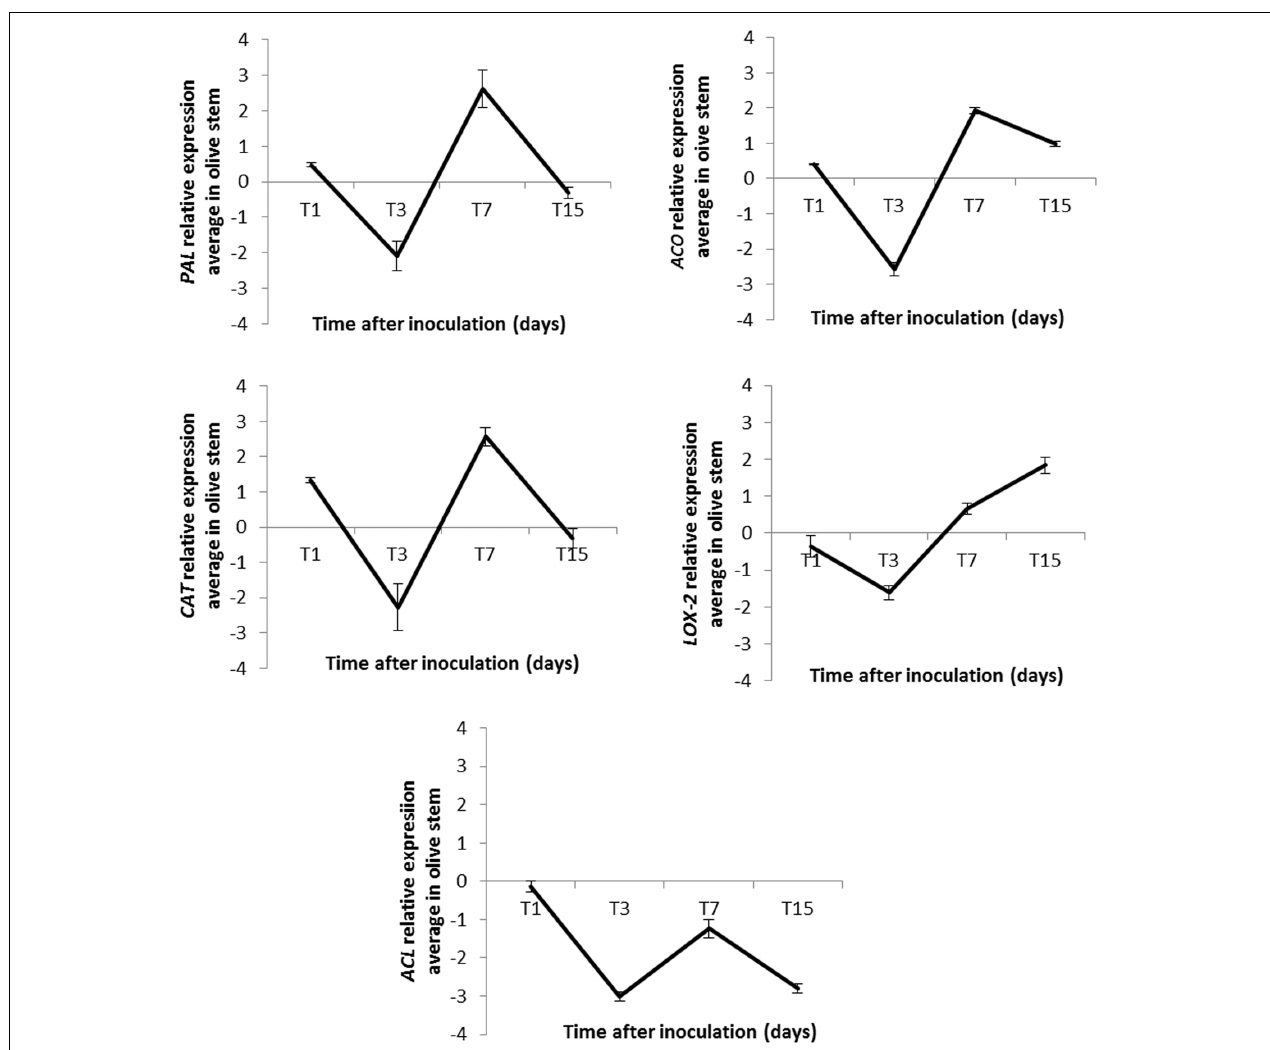
FIGURE 4 | Relative expression (RE) average of five genes identified as up-regulated in stems of inoculated “Arbequina” olive plants at different time points after Pseudomonas fluorescens PICF7 inoculation in roots. PAL , phenylananine ammonia-lyase; ACO , 1-aminocyclopropane-1-carboxylate